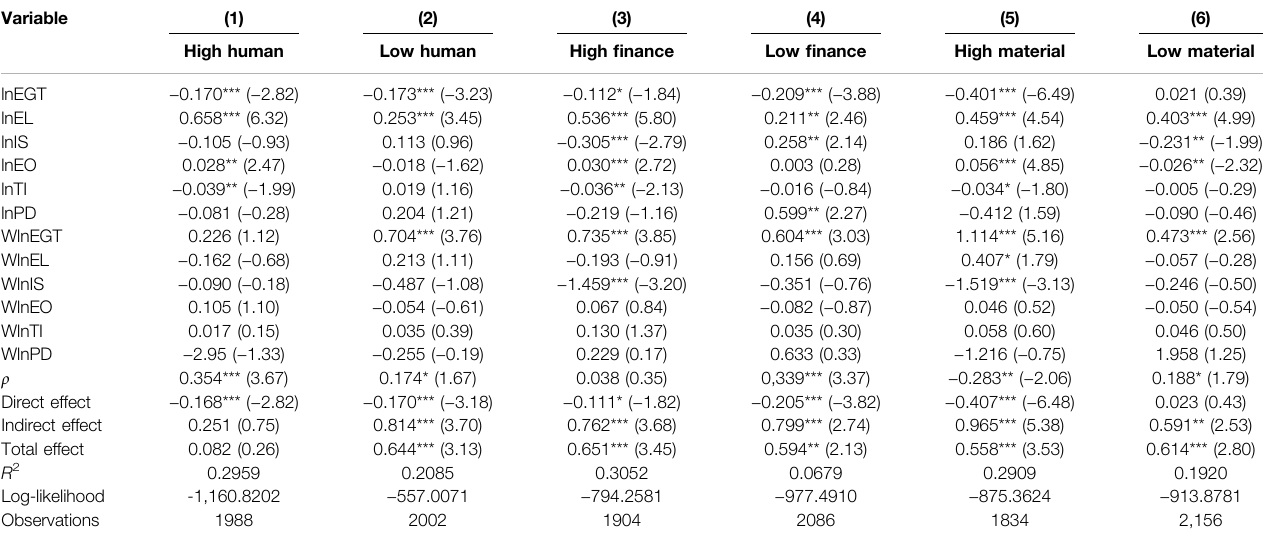
TABLE 7 | Heterogeneity effect